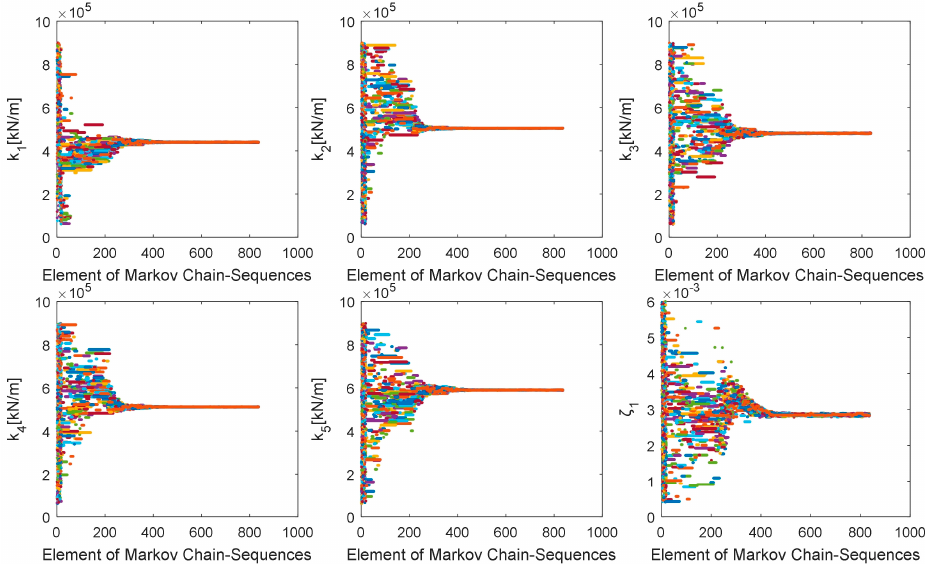
ζ 1 , k 2 , k 3 , k 4 , k 5 , 1